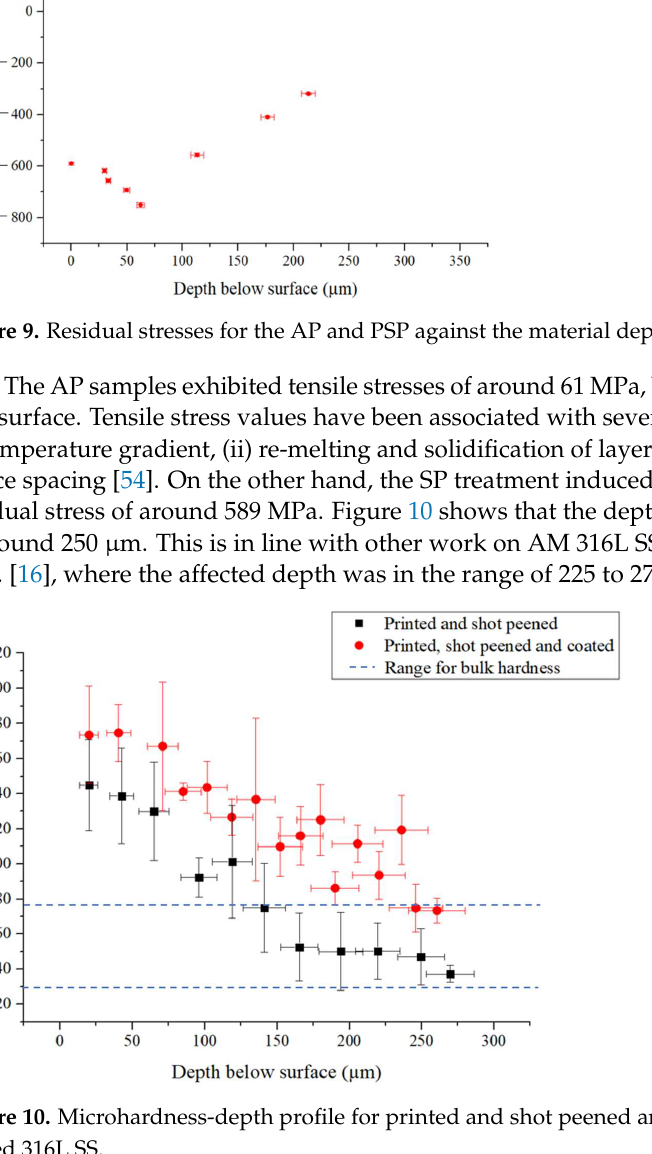
Figure 9. Residual stresses for the AP and PSP against the material depth removed.